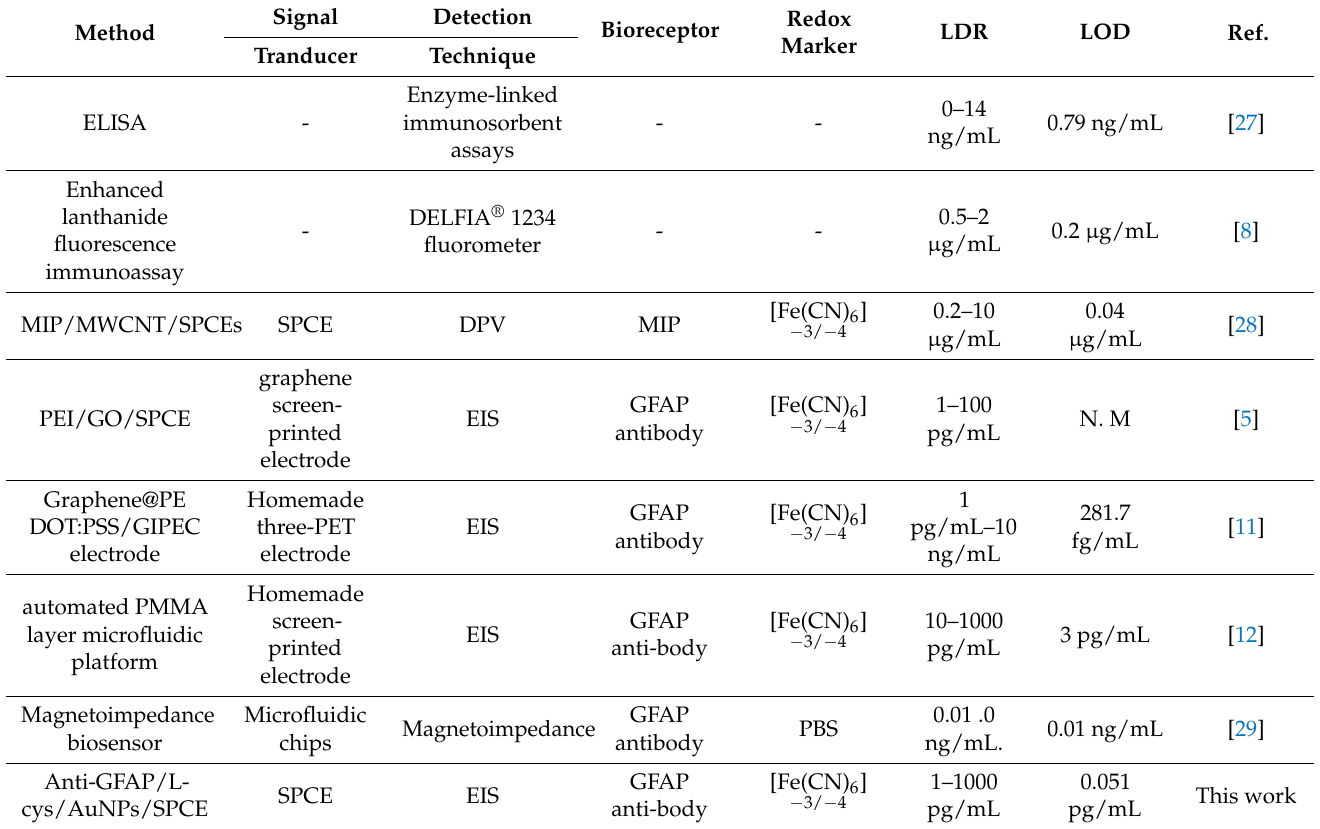
Table 2. The comparison of GFAP with previous studies .